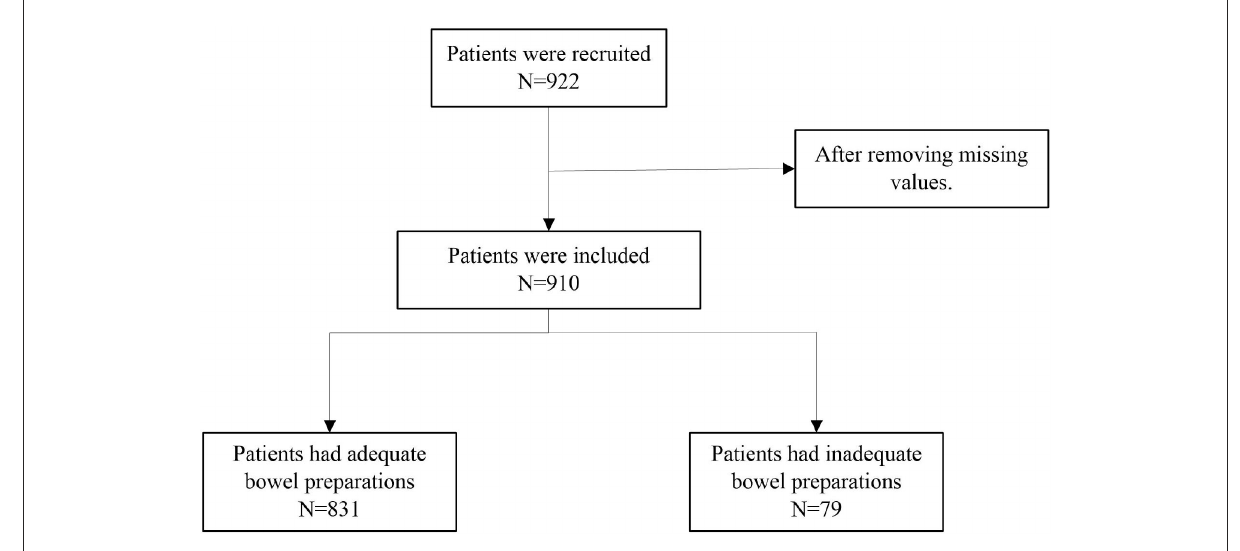
FIGURE1 Flow chart of patients included in the